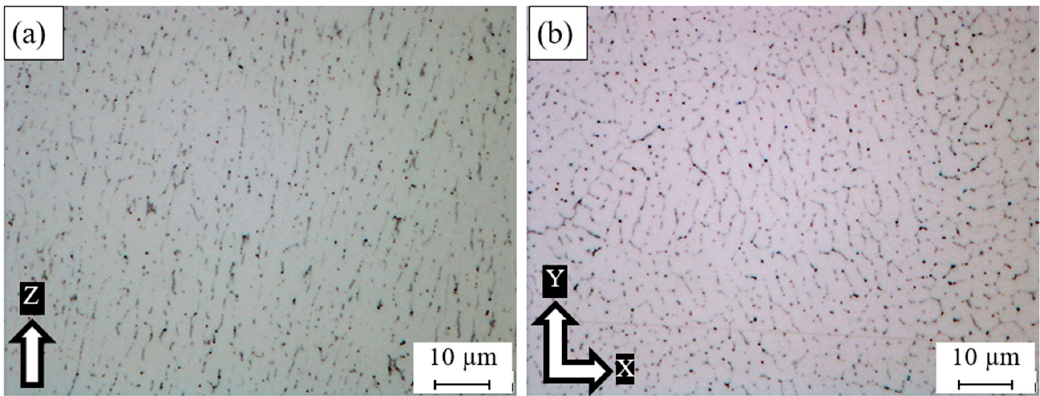
Figure 7. Microstructure grains of the as-built Al6061 sample at a higher magnification: ( a ) along the Z-direction; ( b ) along the XY plane.